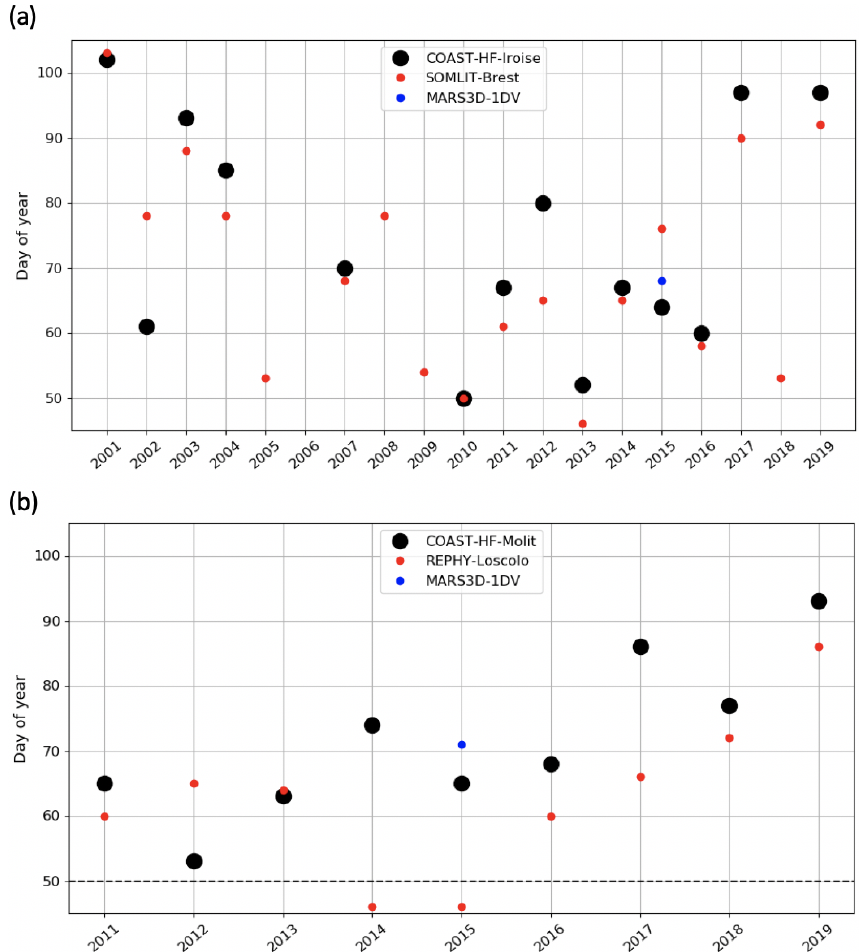
Figure 6. Changes in the IPGP date in (a) the Bay of Brest and (b) the Bay of Vilaine are determined with high-frequency time series (black circles), low-frequency time series (red circles), and with the model (blue circle). The dotted black line represents the date of the COAST-HF-Molit buoy